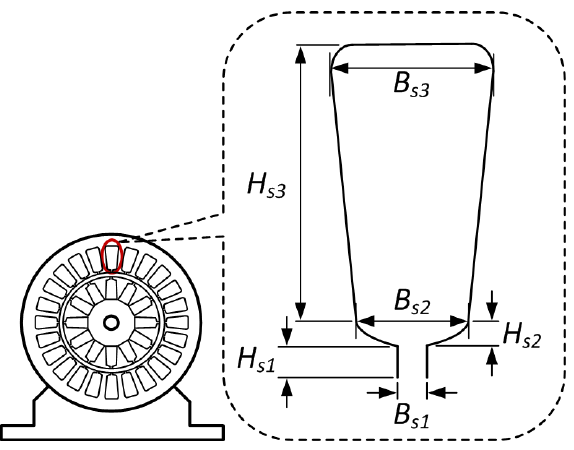
Figure 2. Stator slot shape of induction motor and its